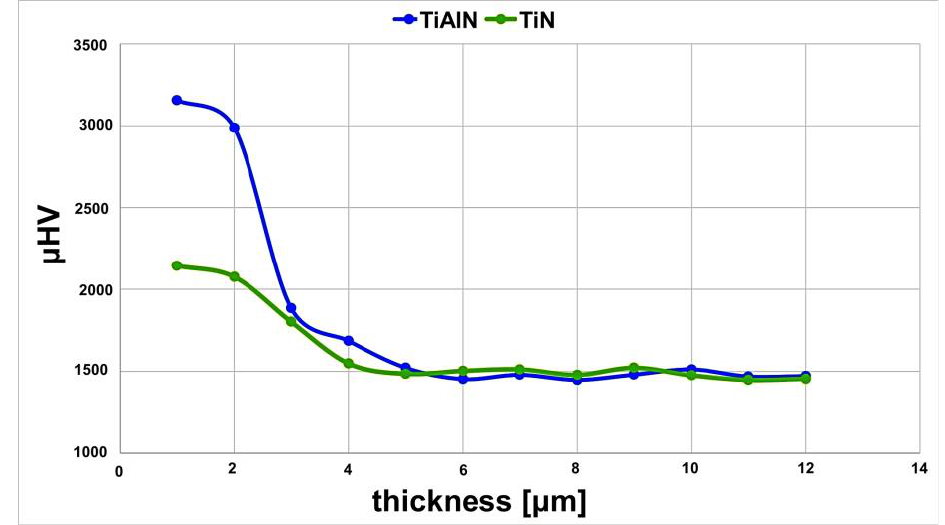
Figure 7. Microhardness profiles across the TiN and TiAlN coatings and substrates.